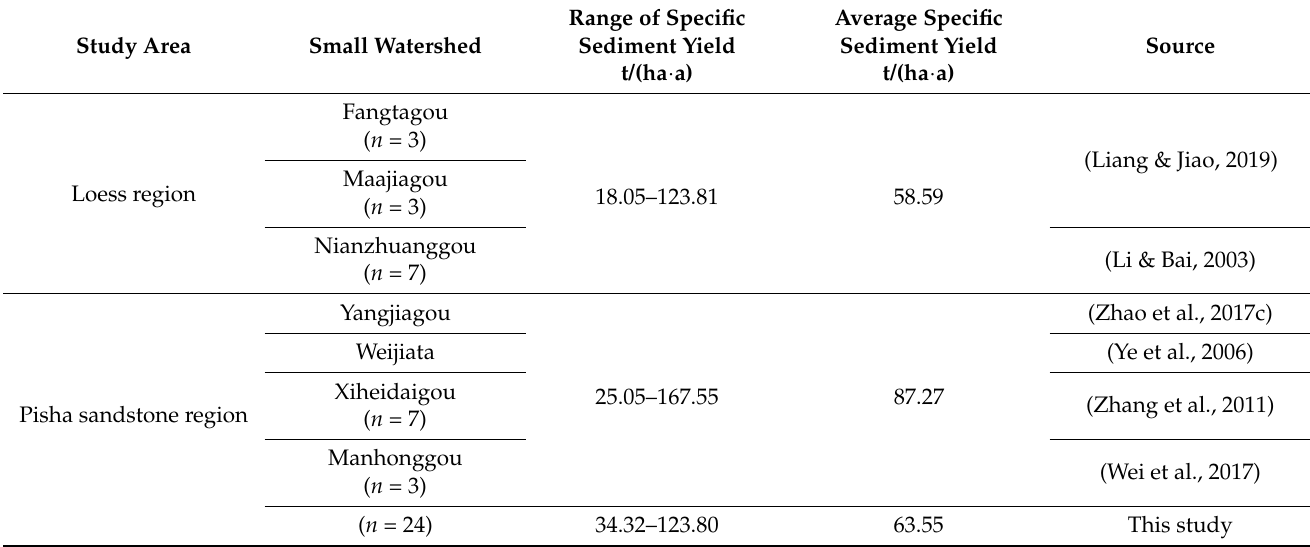
Table 5. Compilation of specific sediment yield for dam-controlled catchments on the Loess Plateau.